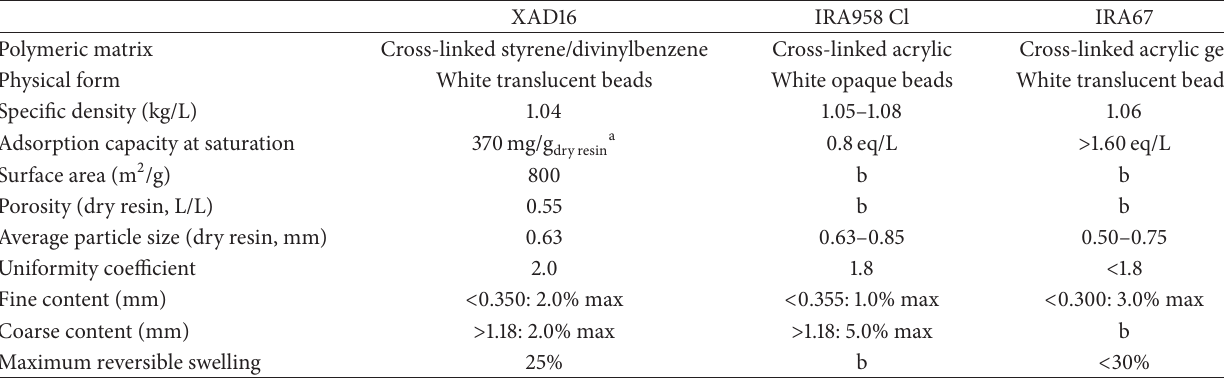
Table 2: Technical characteristics of the tested